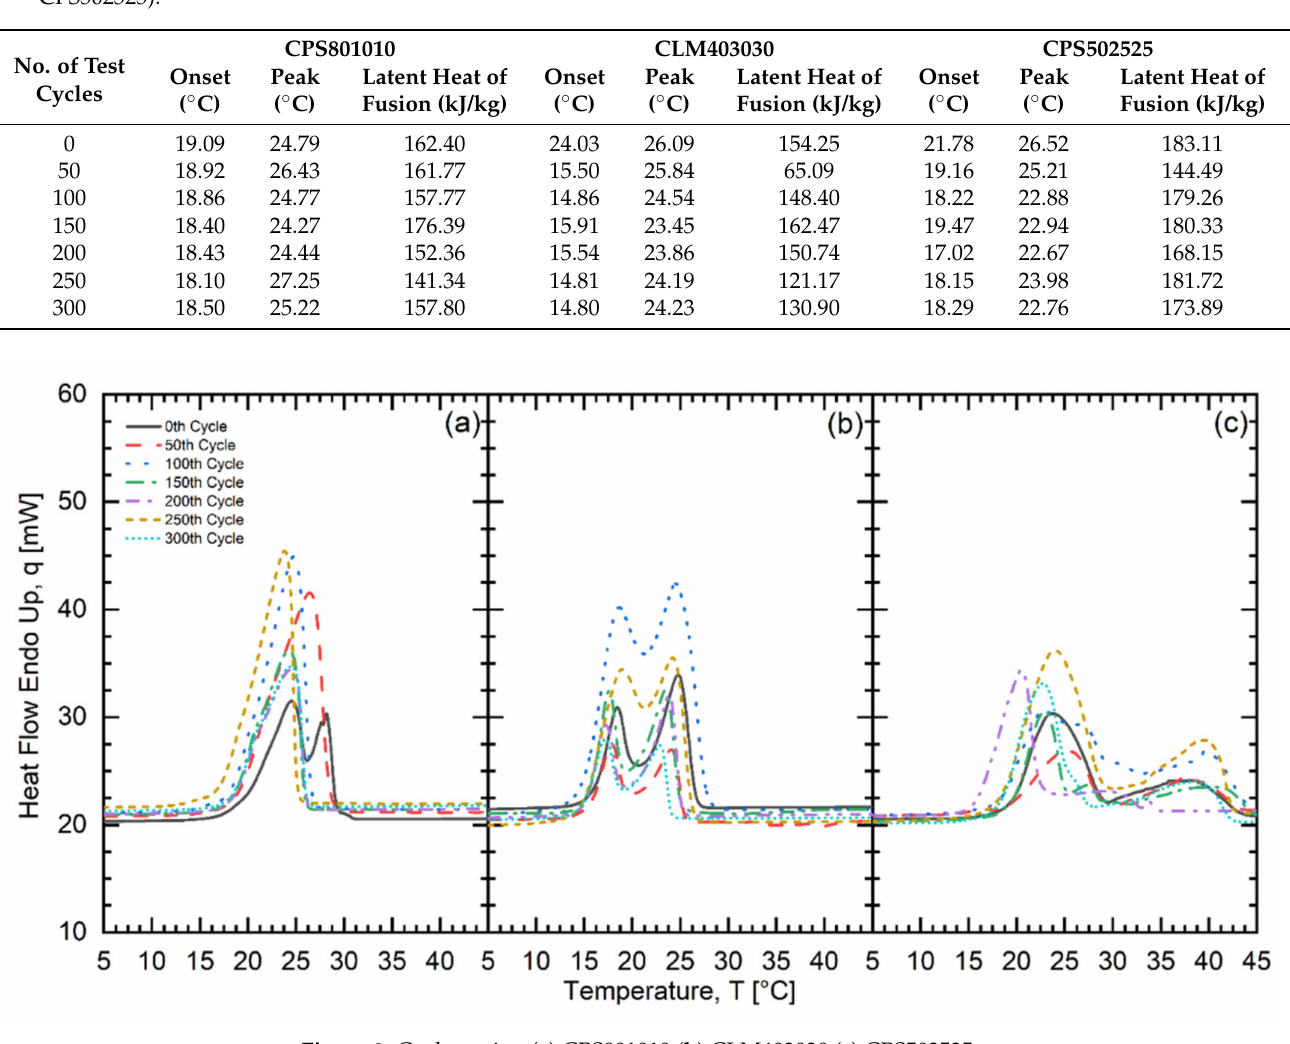
Figure 9. Cycle testing ( a ) CPS801010 ( b ) CLM403030 ( c )